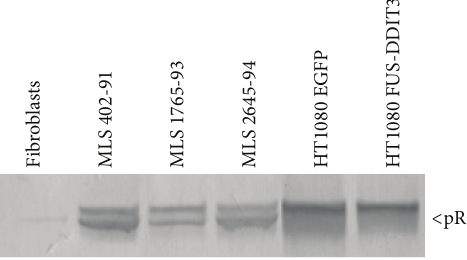
Figure 2: Western blot analysis of RB1 expression in cultured normal human fibroblasts, MLS cell lines, and FUS-DDIT3 or EGFP transfected HT1080 cells.